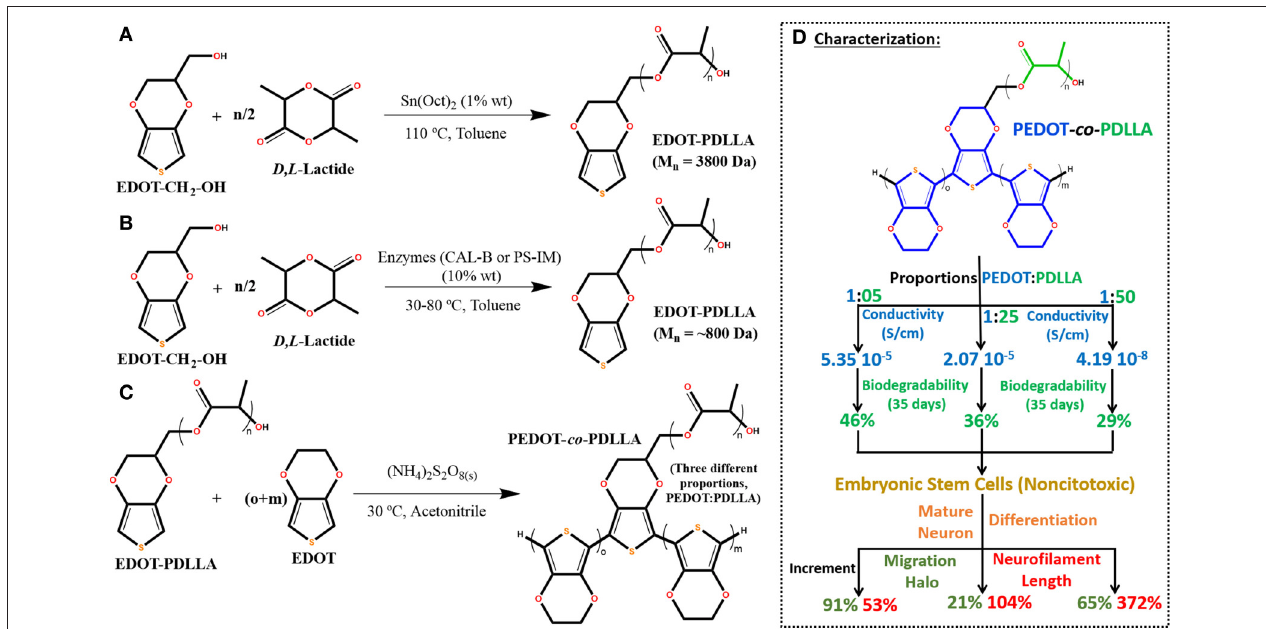
FIGURE 2 | Reactions of obtaining electroactive macromonomer of EDOT-PDLLA (A) via organometallic catalyst, (B) via enzymatic pathway and (C) “grafting through” copolymerization of PEDOT- co -PDLLA. (D) Summary of characterized properties for 1:05, 1:25, and 1:50 ratios (PEDOT:PDLLA) ( da Silva et al., 2018a,b,